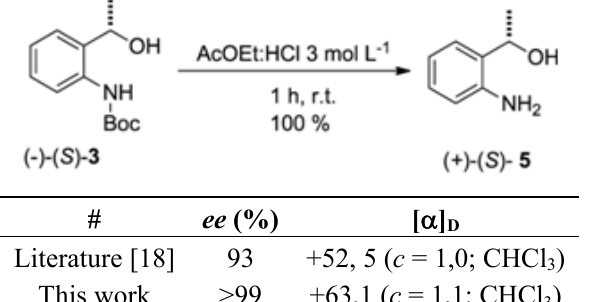
# ee (%) [ α ] Literature [18] 93 +52, 5 ( c = 1,0; CHCl This work >99 +63,1 ( c = 1,1; CHCl